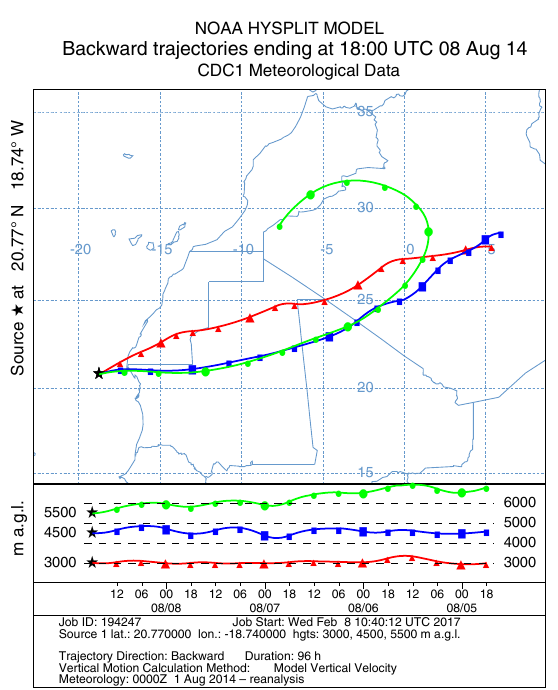
Figure A6. Four-day back trajectories at a height of 3000, 4500 and 5500m on 31 July 2014.